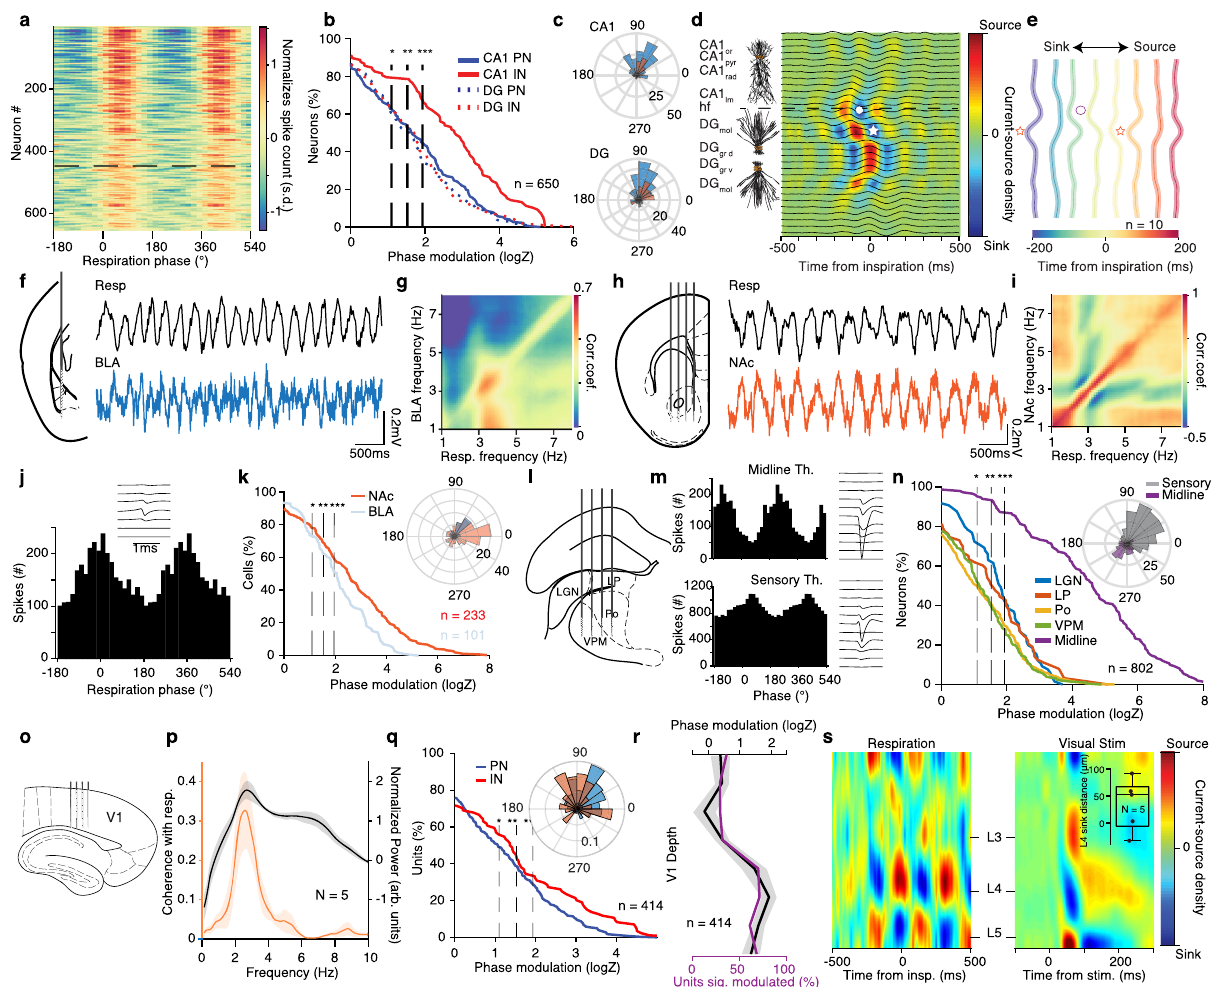
fi ne-timescale modulation of downstream regions by respiration- entrained local and/or OB-originated (at least in mPFC) gamma